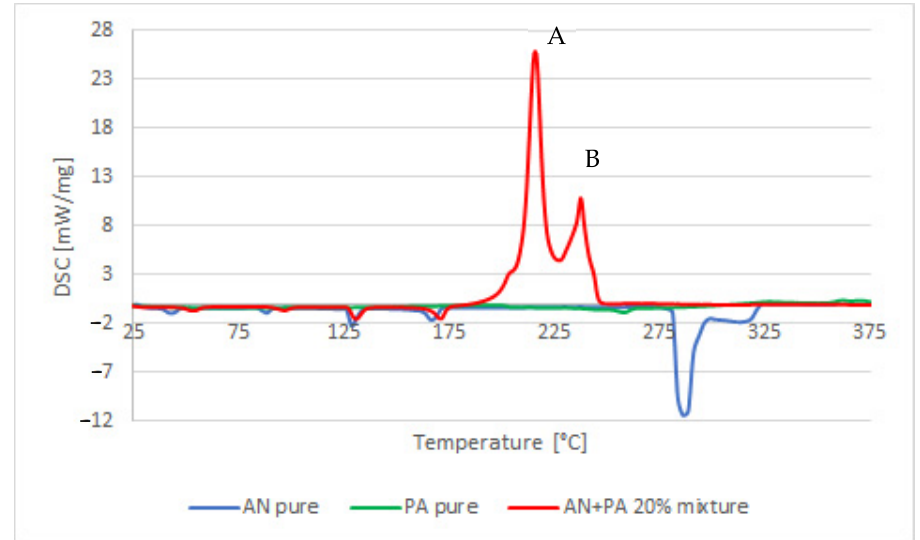
Figure 10. DSC analysis of pure AN, pure PA, and their mixture (20%), heat rate 10 °C/min. Enthalpy of the mixture decomposition process Δ H A = –1033 J/g, Δ H B = –387 J/g (values of A and B reactions are given in Table 5).